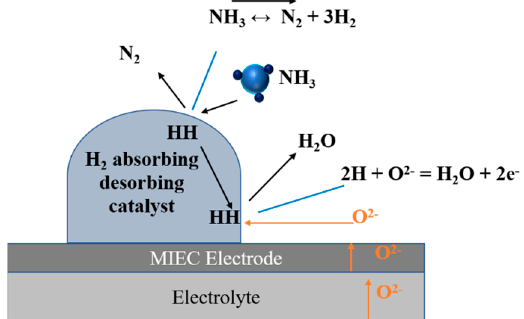
Figure 11. V-I-P for Pd-Ag-LSCF//YSZ//GDC/LSCF cell with hydrogen (hydrogen = 75 mL/min, air = 75 mL/min) and ammonia fuels (ammonia = 50 mL/min, air = 75 mL/min) °C.